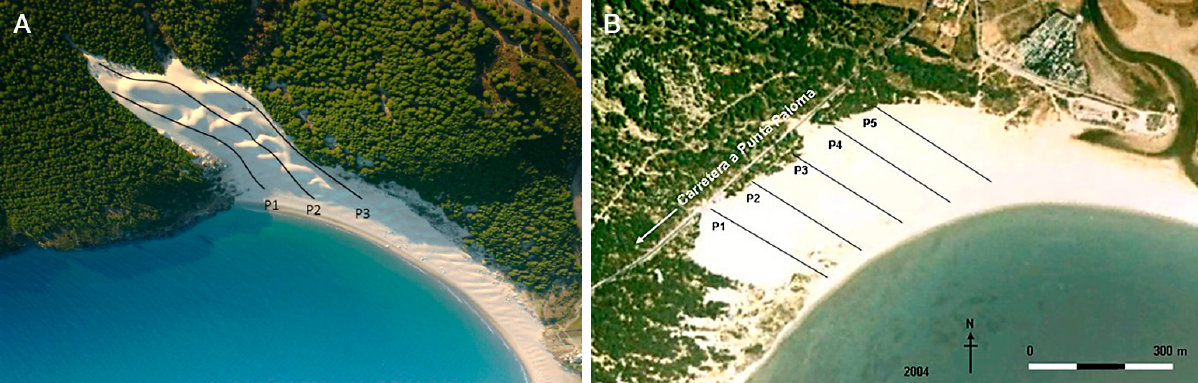
Fig. 5. – Collected dune profiles at the Bolonia (A) and Valdevaqueros (B) dunefields. Pine groves were planted in the mid-20th